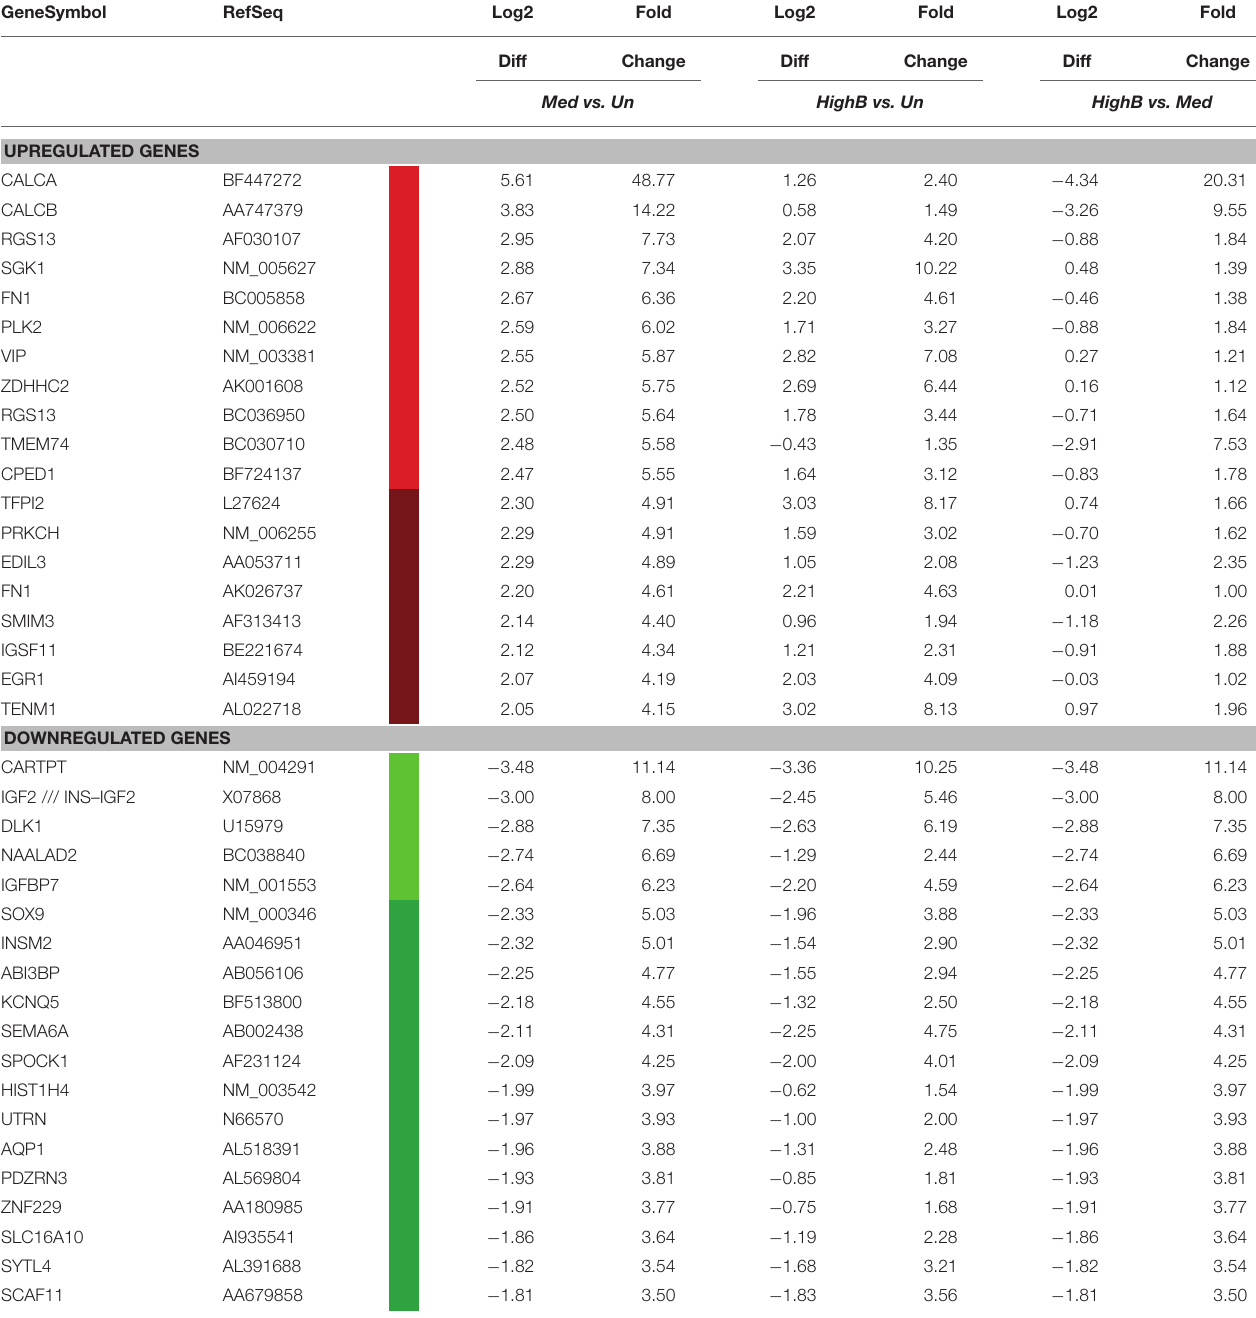
TABLE 5 | Differential Genes expressed by FtMt overexpressing SH-SY5Y neuronal cells.